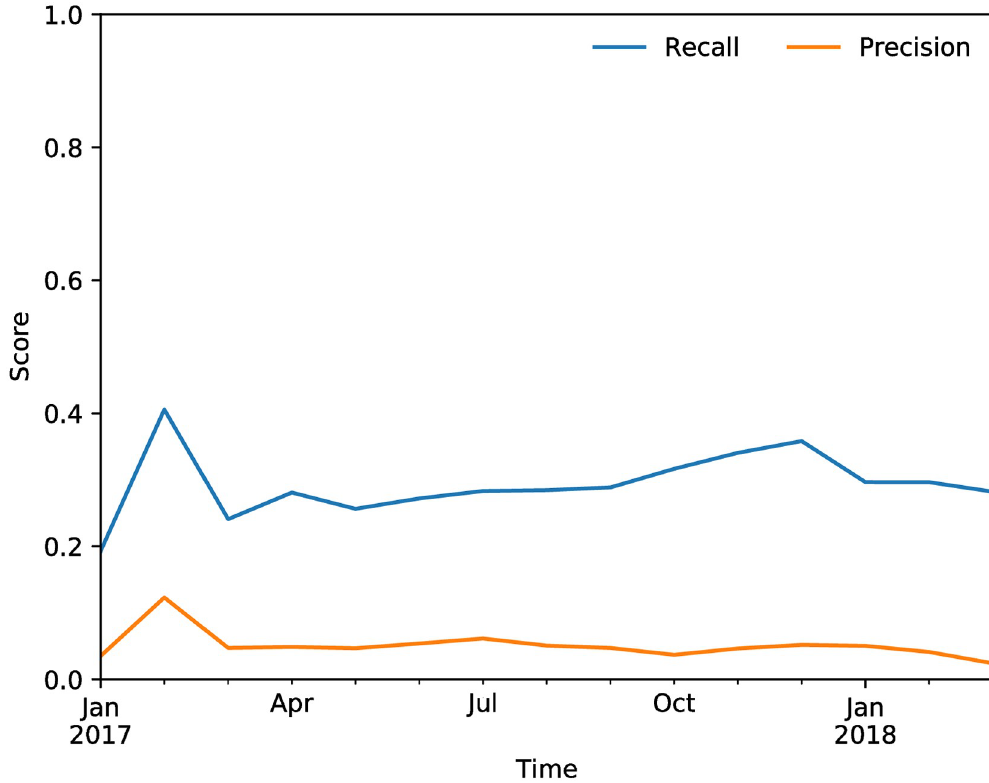
Fig 10. Recall@K and Precision@K of the 2-step model on the target perimeter.